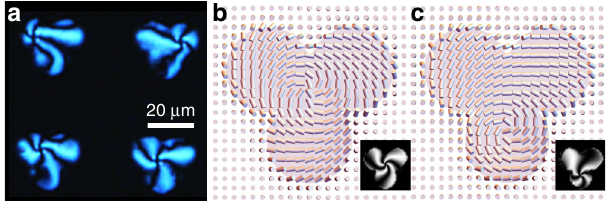
Fig. 4 Control of defect location. a Polarizing microscope image of 5CB in contact with trefoil posts. b Section through a calculated structure with defect located at the center of the trefoil; c a structure with defect centered on one of the disks. Insets: Simulated POM images for each